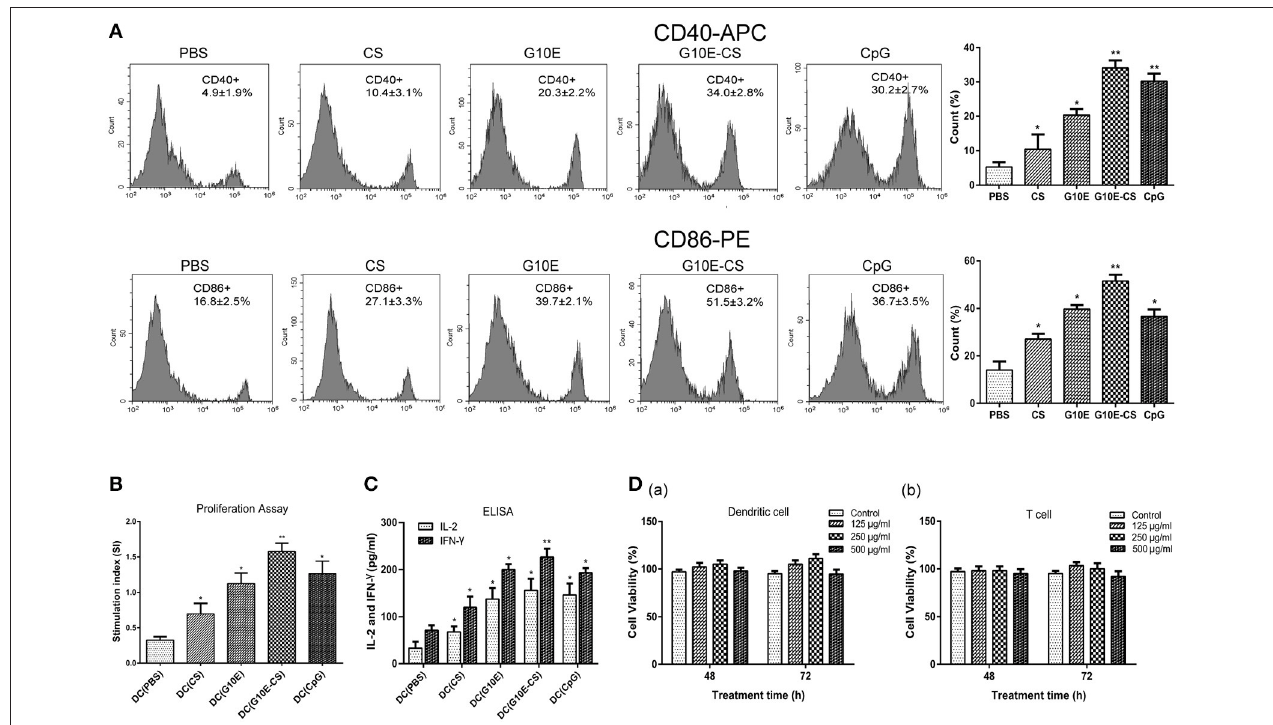
FIGURE 3 | G10E-CS induce the activation of dendritic cells and lymphocyte in vitro . (A) The expression of the co-stimulatory molecules CD40 and CD86 on the surface of stimulated dendritic cells (DCs). DCs of C57BL/6 mice were incubated withG10E-CS, G10E, CS, CpG, or PBS for 48h and the expression of CD40 and CD86 were detected by flow cytometry. Values represent mean ± SD ( n = 5). * p < 0.05, ** p < 0.01. (B) The analysis of T lymphocyte proliferation induced by stimulated DC cells. DCs of C57BL/6 mice were incubated with CpG, G10E-CS, CS, G10E, or PBS for 48h and then they were cocultured with lymphocyte from C57BL/6 mice for 72h. The lymphocyte proliferation was measured by CCK-8 assay. (C) The expression of cytokines (IFN- γ , IL-2) in the supernatant of lymphocytes induced by the stimulated DC cells. The supernatants of mixed cells were assayed for IL-2 and IFN- γ using ELISA assay. Data represent mean ± SD representative of three independent experiments. * p < 0.05, ** p < 0.01. (D) Cytotoxicity of G10E-CS microparticles on dendritic cells (DCs) (a) and T cells (b) . DCs and T cells were incubated with different concentrations (125, 250, and 500 µ g/ml) of G10E-CS microsphere for different incubation times (48 and 72h) and cytotoxicity of G10E-CS was assessed by CCK-8 assay (mean ± SD, n =